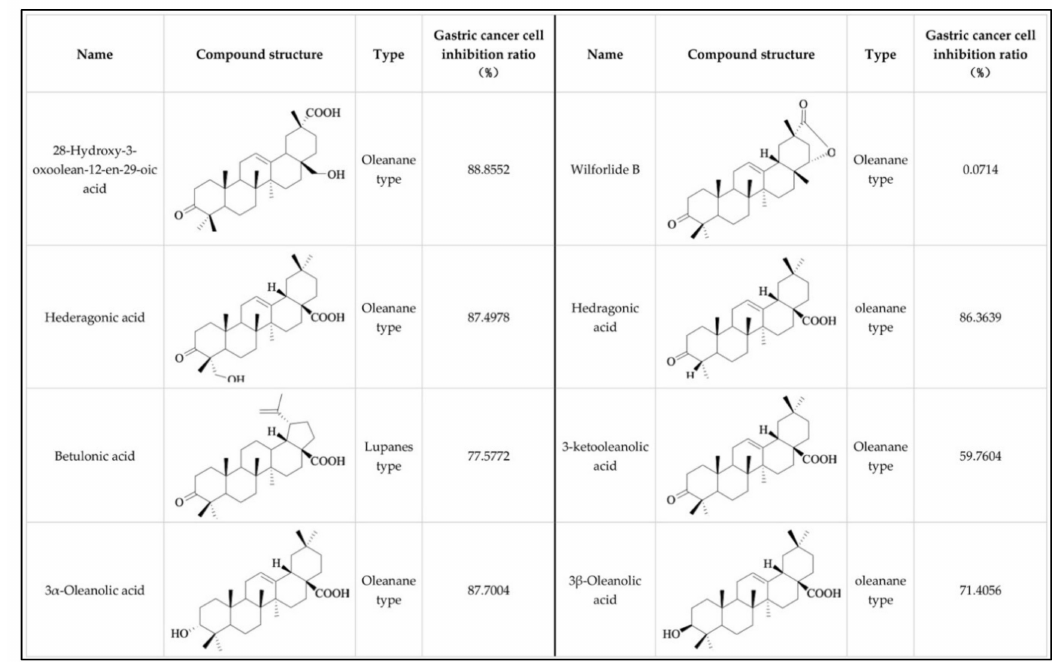
Figure 1. The molecular structure of several oleanane-type triterpenoid acid extracted from the Celastrus orbiculatus Thunb. Their names and types, and their inhibition rate to gastric cancer cells are shown in the figure.